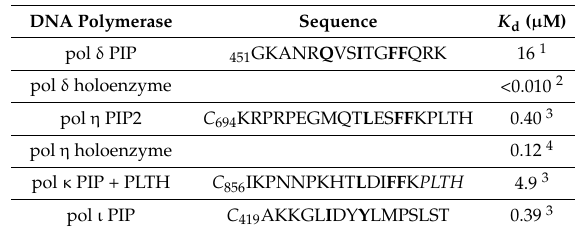
Table 1. Apparent dissociation constants ( K d ) of DNA polymerase holoenzymes or PIP peptides with PCNA. Conserved amino acid residues relative to a consensus sequence are in bold. Italic cysteines indicate that these amino acid residues were included in addition to the native RIR peptide to facilitate the